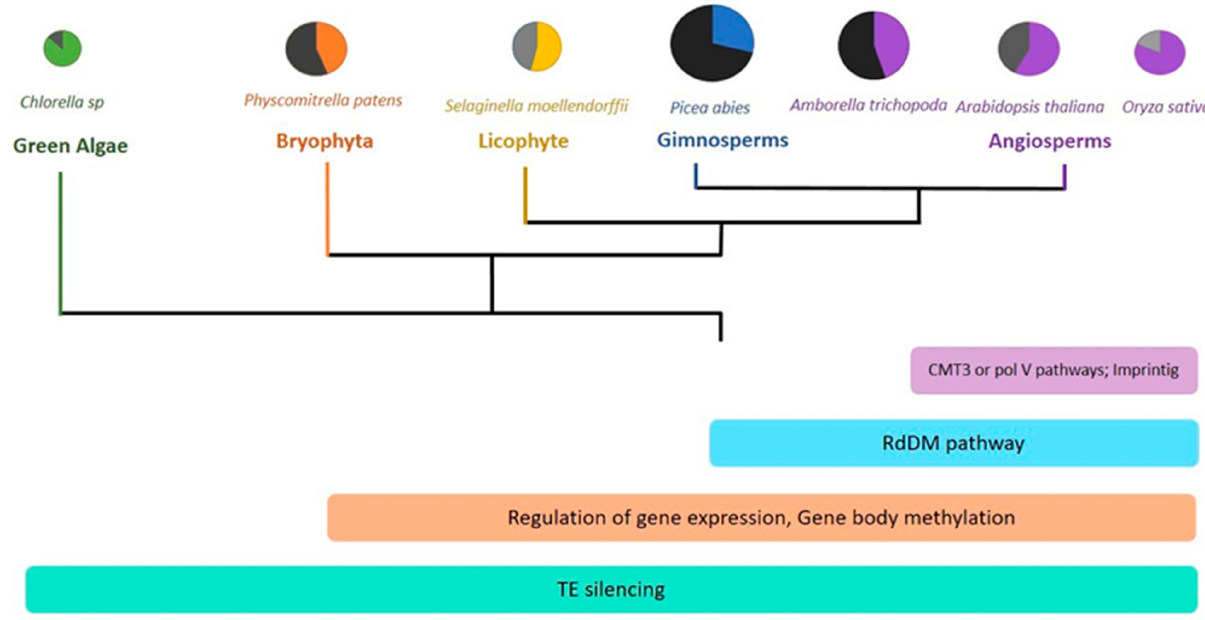
Figure 3. DNA methylation during plant evolution. The diameter of the colored circles represents the genome size of selected species; the dark slice represents the percentage of repeated sequences, and the intensity of the gray represents the level of global DNA methylation. Across plant evolution, DNA methylation assumes new roles represented by colored rectangles. The TE silencing constitutes the most conserved function of methylation. More recently, novel regulation pathways have emerged.